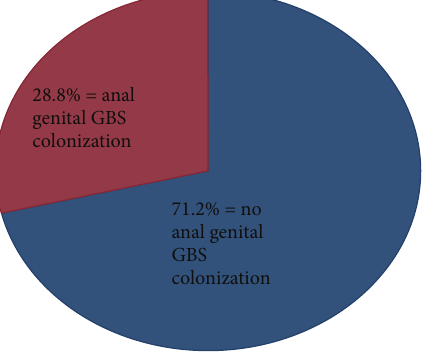
Figure 1: GBS anogenital colonization.